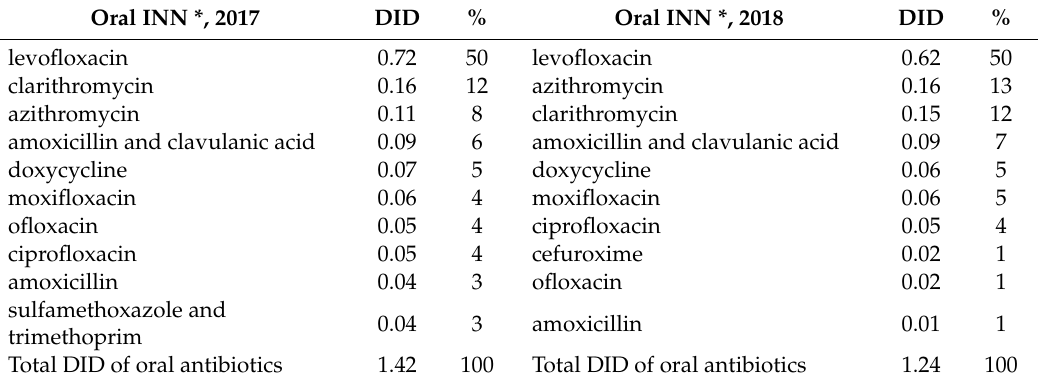
Table 1. Comparative analysis of the consumption of the top 10 oral antibiotics for the period 2017–2018.